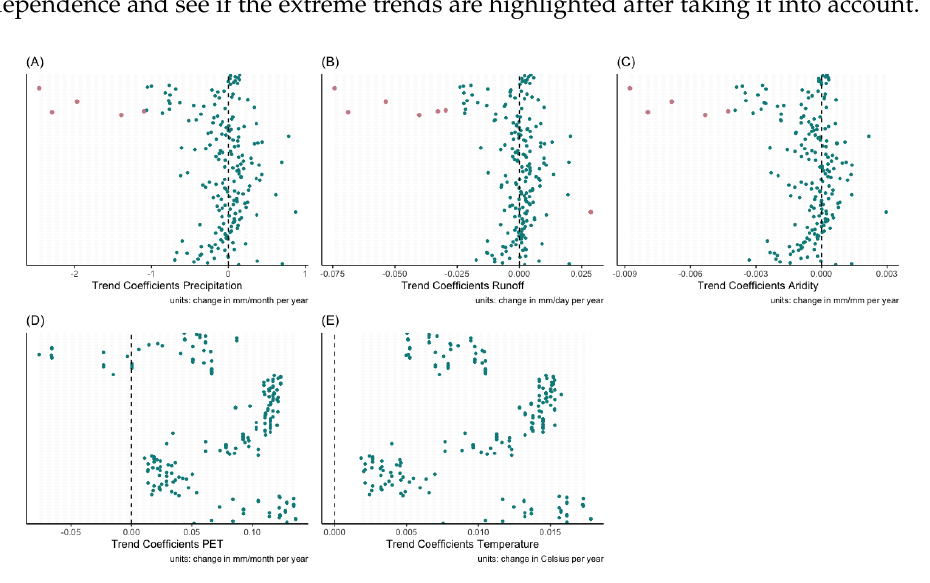
Figure 3. Trends for ( A ) Precipitation, ( B ) Runoff, ( C ) Aridity, ( D ) PET and ( E ) Temperature for 199 meteorological stations in the Central American Region. The dashed black vertical line corresponds to zero trend or no change over the years 1970–1999. Outliers were detected using the criterion of 5 mean absolute deviations (MAD) away of the median for each variable, and are highlighted with pink. Each point in the y-axis represents a meteorological station in its order from 1–199 (from South to